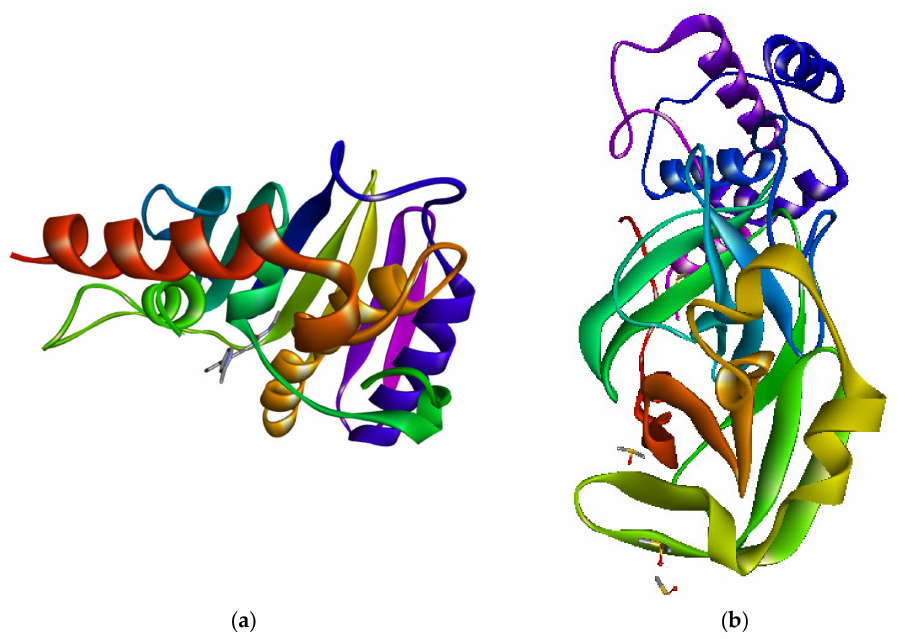
Figure 1. ( a ) E. coli DNA Gyrase B 24 kDa ATPase domain in complex with 1-ethyl-3-[8-methyl-5-(2-methyl-pyridin-4-yl)- isoquinolin-3-yl]-urea. ( b ) SARS-CoV-2 main protease with unliganded active site.